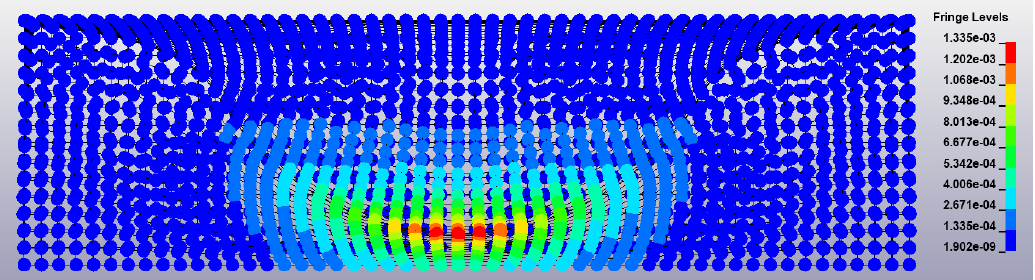
Figure 4. Mid-section deformed shape of the impact zone and through-the-thickness von Mises stress distribution (70 mm pad—units, GPa).